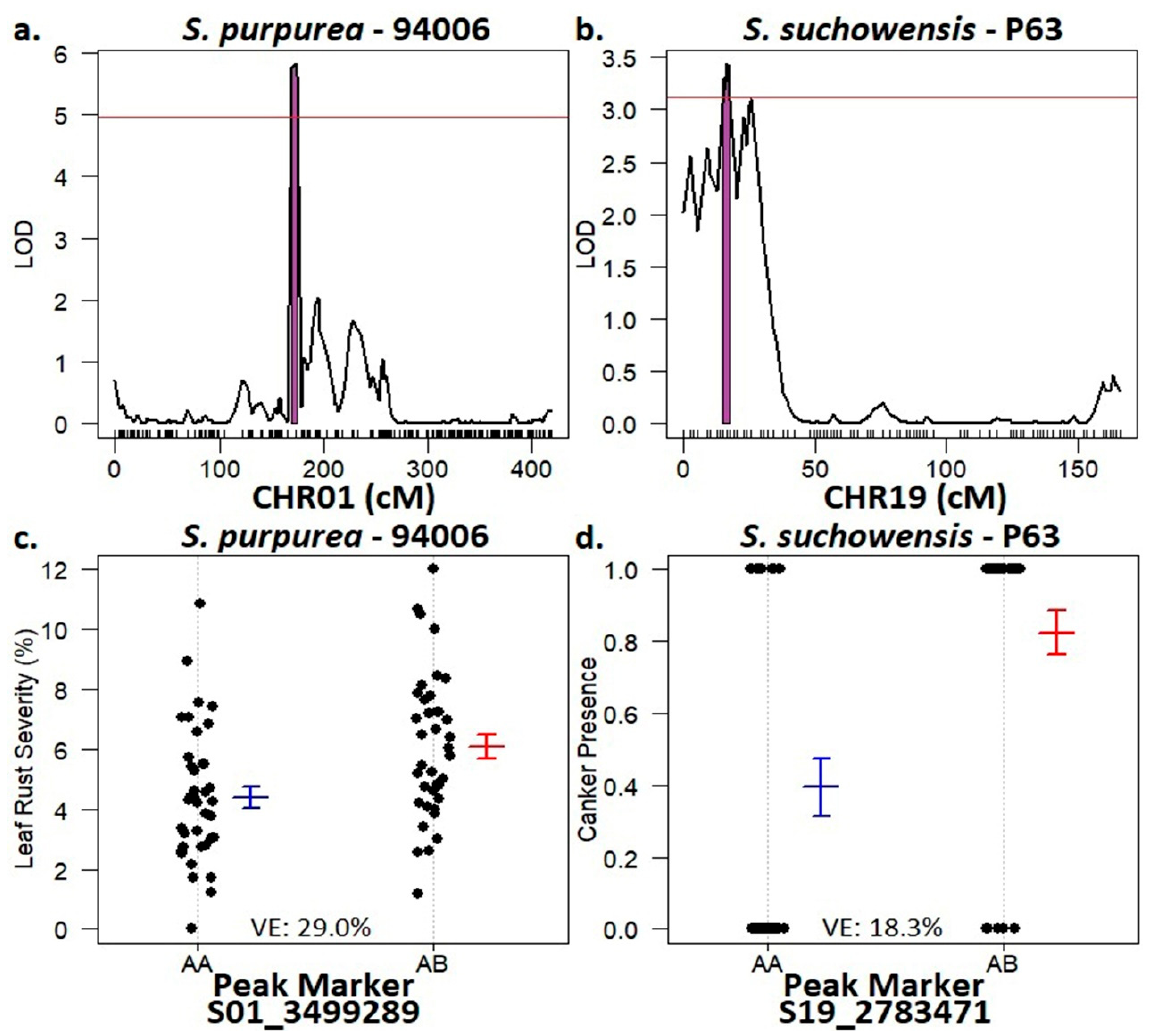
Figure 3. QTL results for leaf rust severity and stem canker presence in the S. purpurea × S. suchow- ensis F 1 family. ( a ) Leaf rust severity QTL on S. purpurea 94006, CHR01. ( b ) Stem canker QTL on S. suchowensis P63, CHR19. (Panels a and b ) The red line indicates the 1000-permutation genome wide significance threshold while the purple area shows the region of the QTL. ( c ) Zygosity of the peak marker, S01_3499289 from CHR01, associated with leaf rust severity in relation to genotype means. ( d ) Zygosity of the peak marker, S19_2783471 from CHR19, associated with stem canker presence in relation to genotype means. (Panels c and d ) Blank dots show individual genotype means, bar and whiskers are the mean and standard error of each marker type.